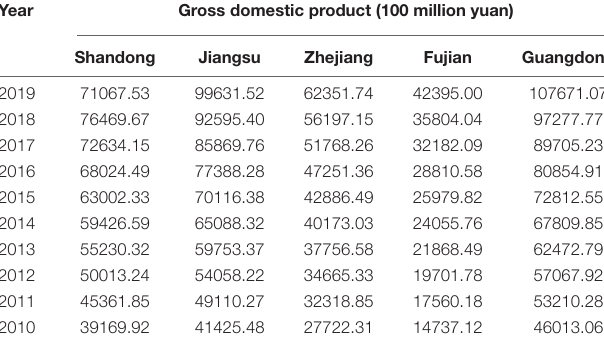
TABLE 2 | GDP in the five provinces